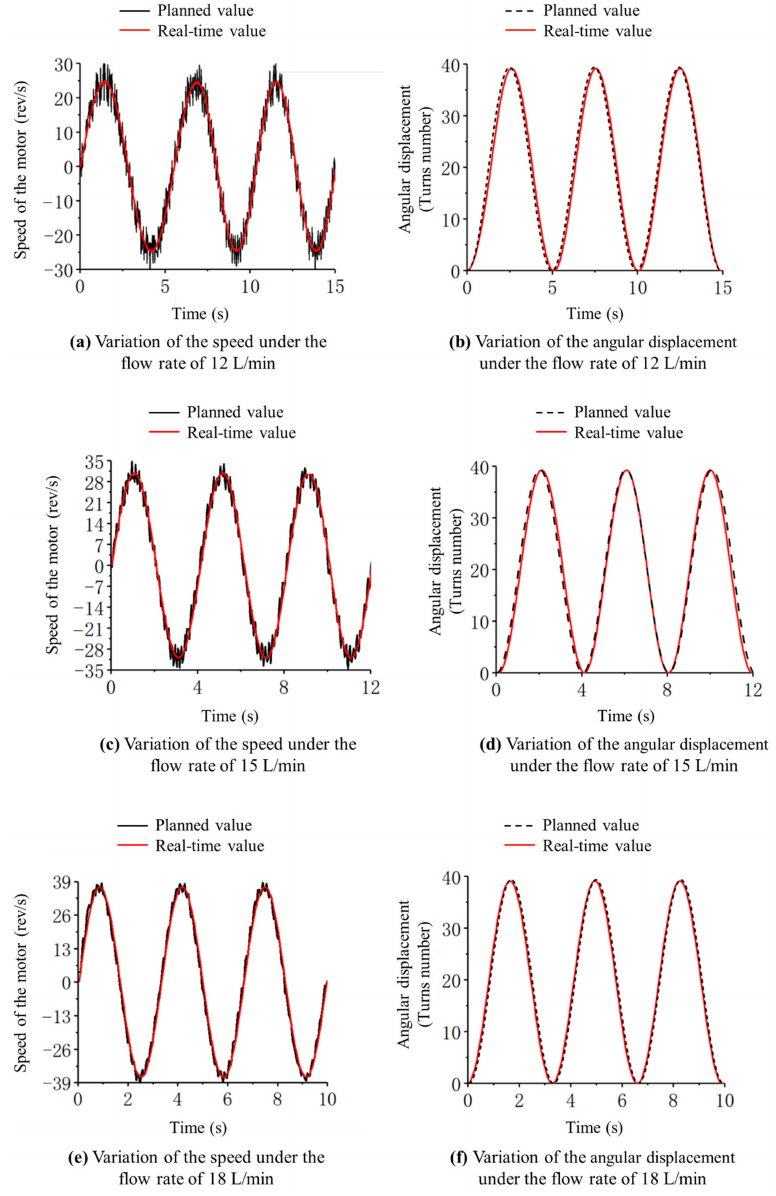
Figure 13. Variation of the speed and angular displacement in the no-load